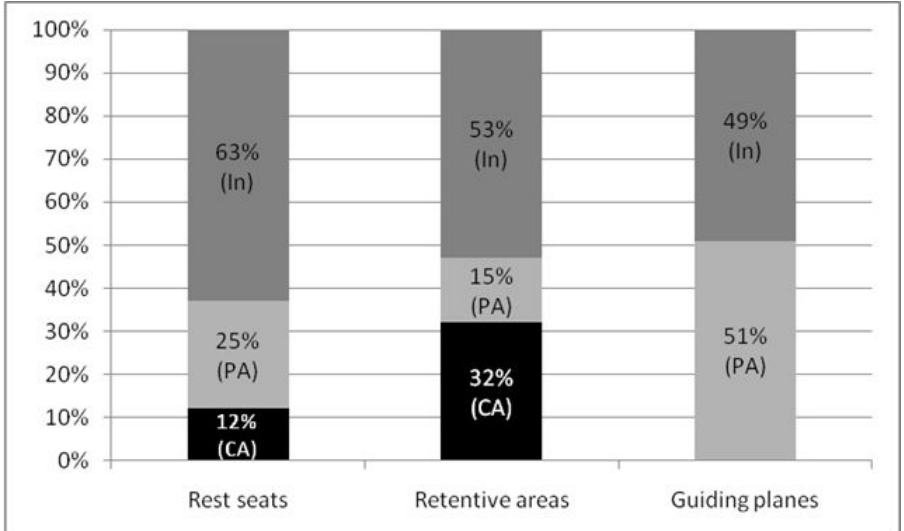
Fig. 1. General assessment of master casts for mouth preparation. Inappropriate (In), Partially Appropriate (PA), Completely Appropriate (CA).